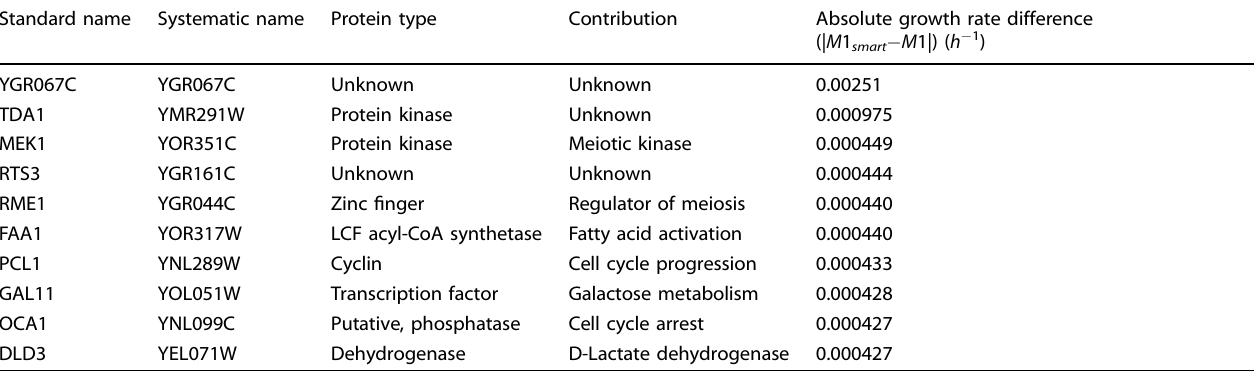
Table 1. Selected deletion mutants.